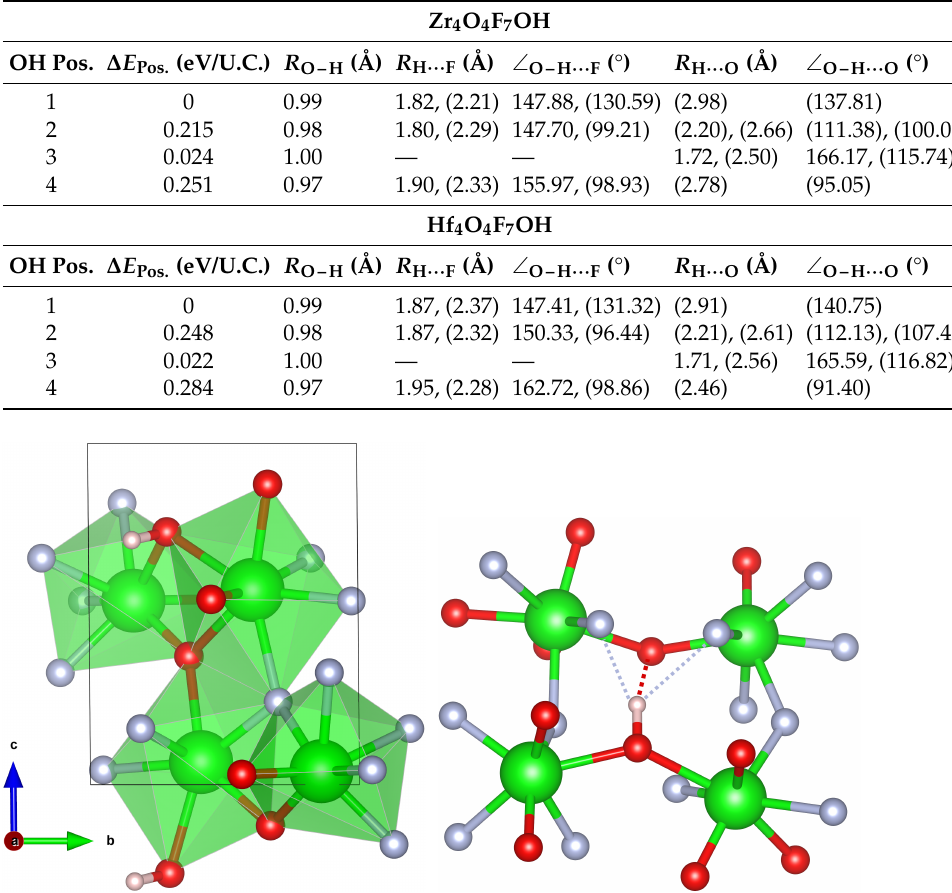
Table 6. Position of hydroxylation (OH Pos.), energy difference per unit cell (U.C.) between the positional isomers with respect to the most stable isomer ( ∆ E Pos. ), hydroxyl group bond length ( R O–H ), H-bond length ( R H ··· X ), and angle ( ∠ O–H ··· X ) within the mono-hydroxylated zirconium oxofluoride (top) or hafnium oxofluoride (bottom); H-bonds classified as weak by distance or angle are given in parenthesis.